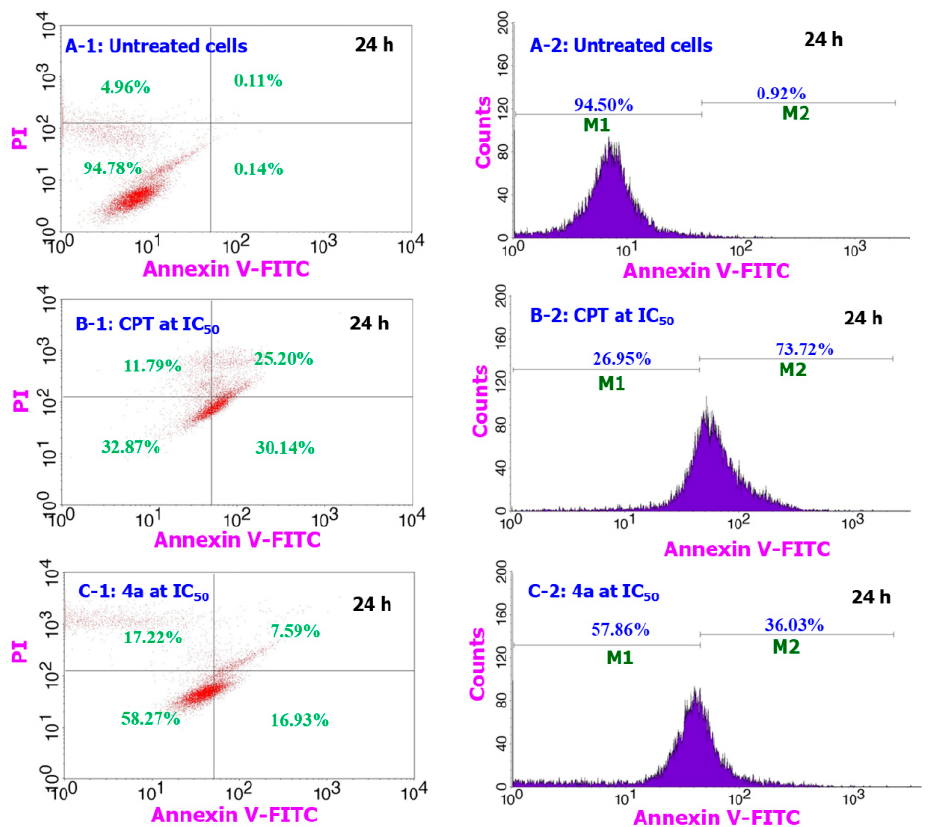
Figure 5. Comparison of apoptosis studies for the compound 4a ( B ) with that of positive ( C ) and negative controls ( A ) for the A549 cells following the incubation period of 24 h.